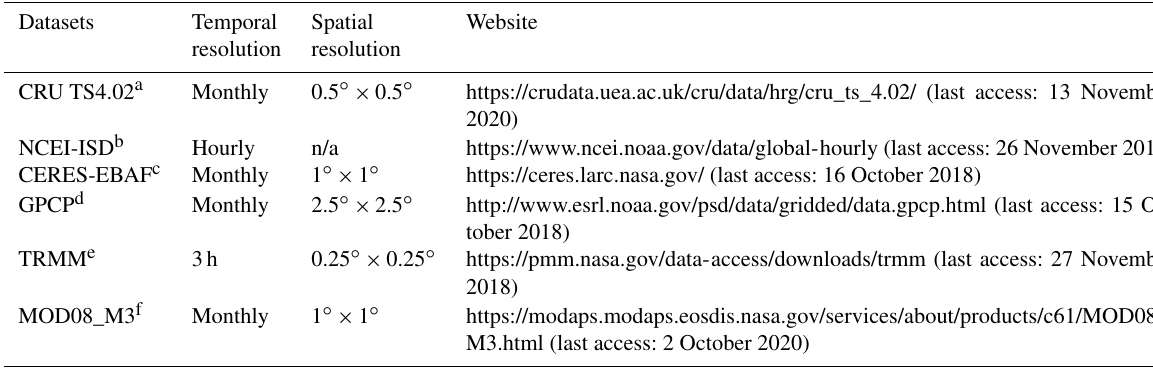
Table 8. Datasets for meteorological evaluation.